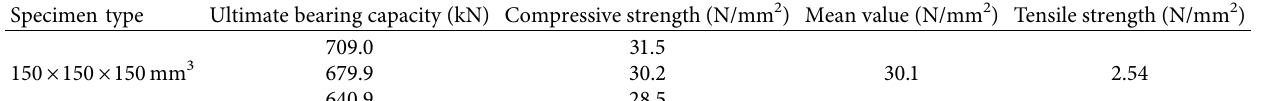
Table 1: Characteristic value of cubic concrete compressive